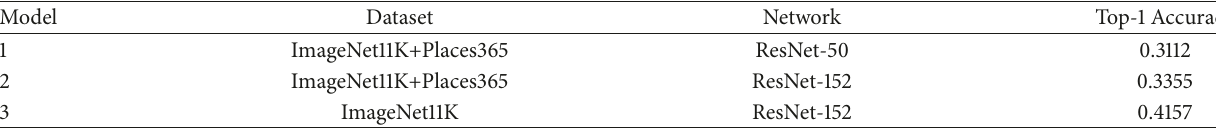
Table 1: Pretrained deep CNN models.